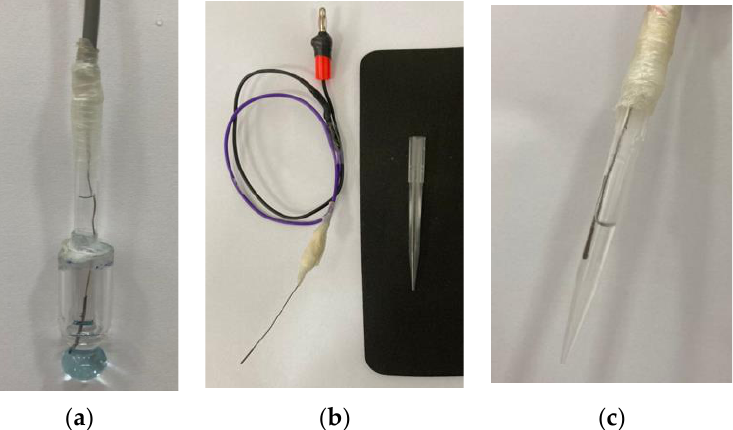
Figure 3. Modification of the electrodes: ( a ) Internal electrode completed; ( b ) Mounted electrode